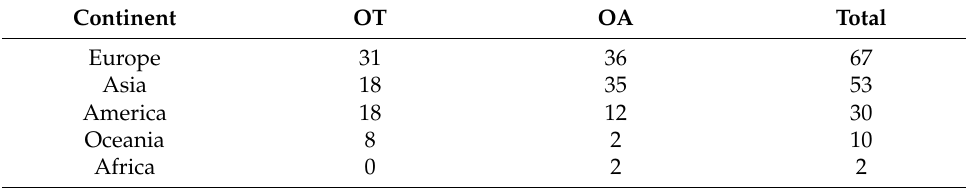
Table 5. Distribution by